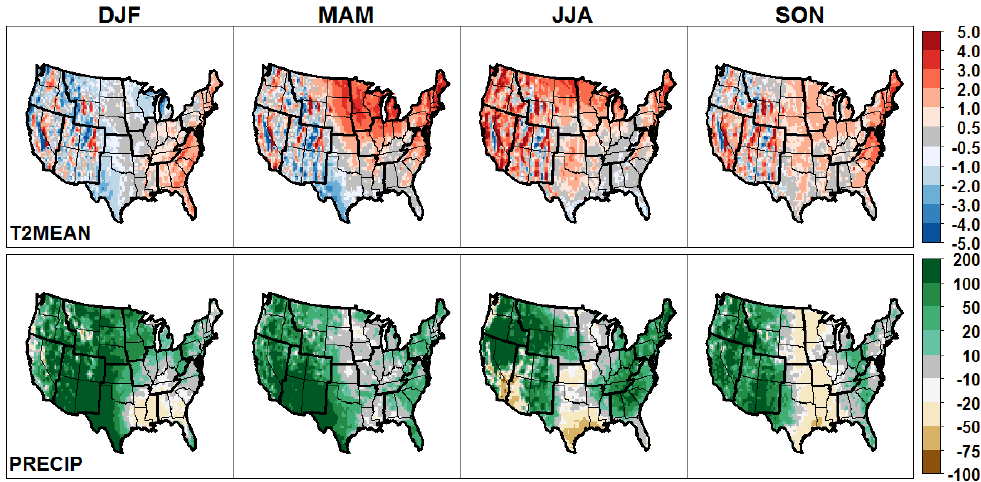
Figure 2. Seasonally averaged biases in daily mean 2m temperature compared to CFSR (K) and precipitation relative to NARR (%), simulated by downscaling CESM with WRF for 1995–2005.